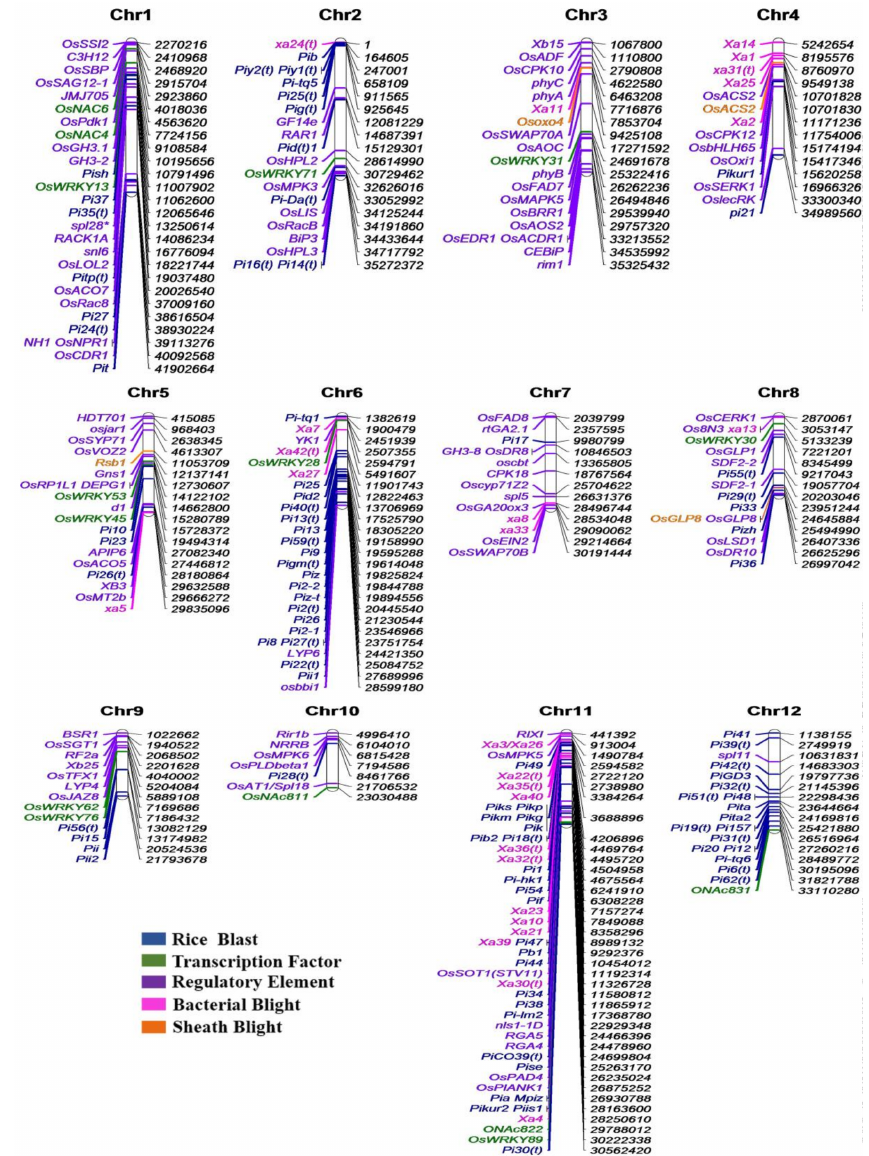
Figure 3. Distribution of major resistance genes according to theirphysical location on the respective chromosomes. Different disease resistance gene categories plotted on the chromosomes are indicated by five color codes. The plot was generated on the basis of the nearest linked molecular